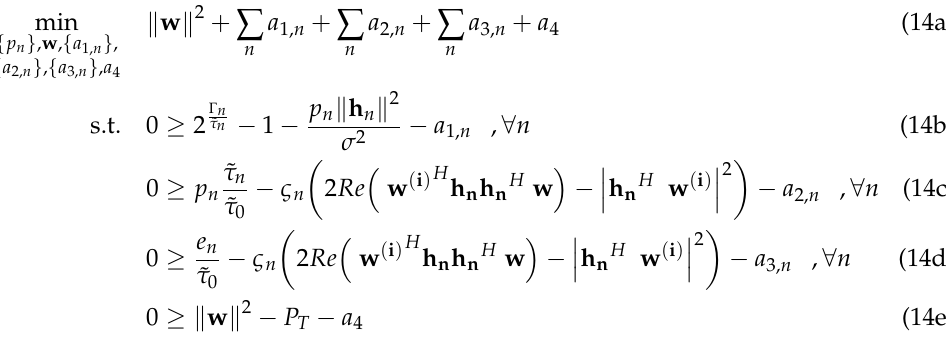
Algorithm 2: Proposed algorithm based on Problem (14) and the bisection search method set initial values for τ 0, min and τ 0, max , where ˜ τ ∗ i = 0